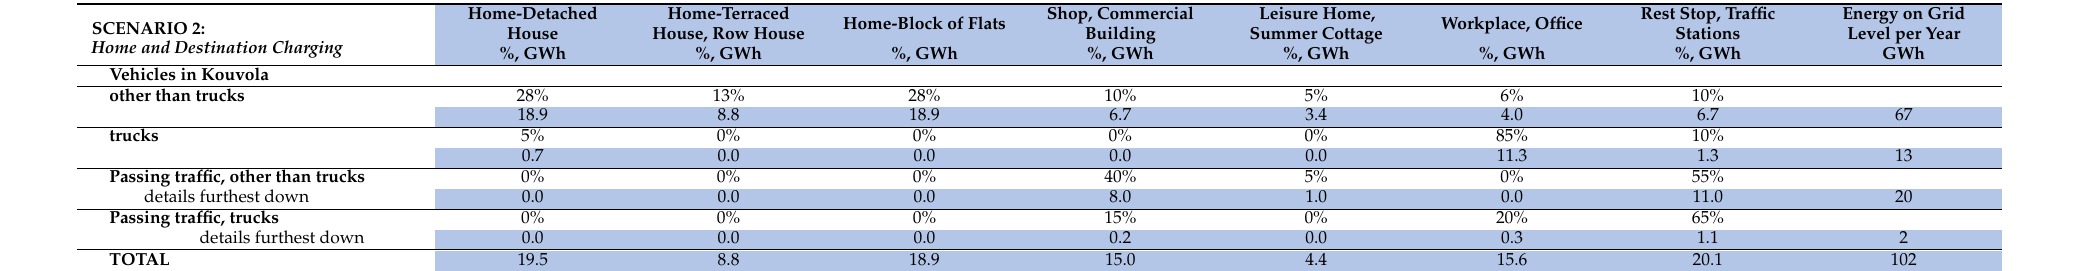
Table A5. Kouvola-based and passing traffic: subdivision of additional energy into user groups. Percentages indicate the share of consumption